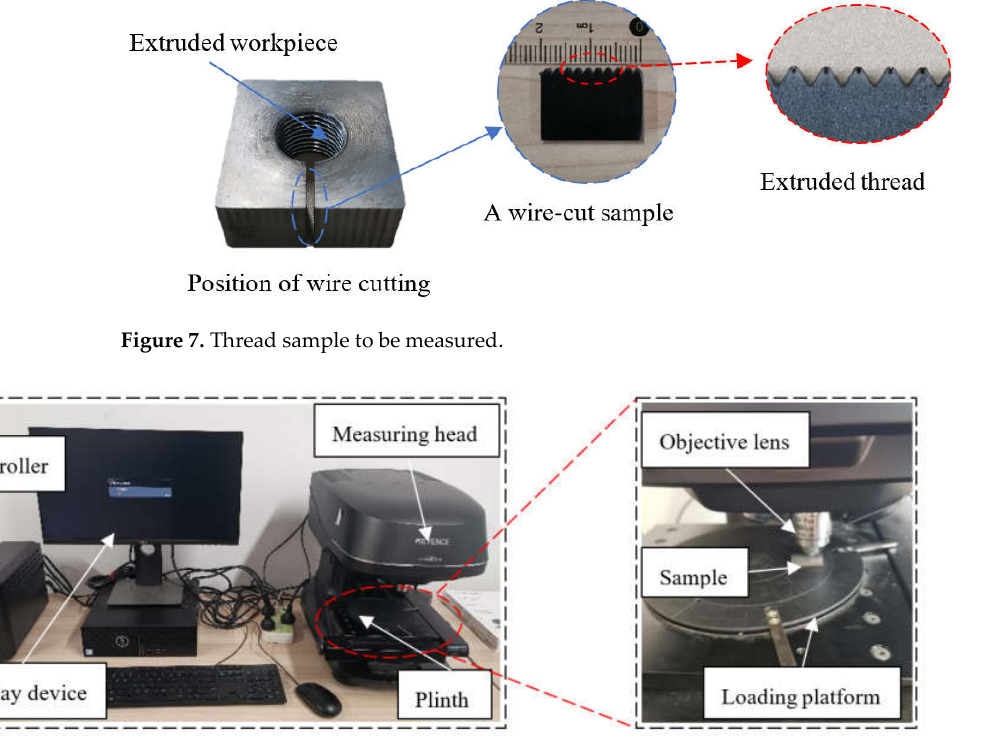
Figure 8. Laser microscopic system for shape measurement.